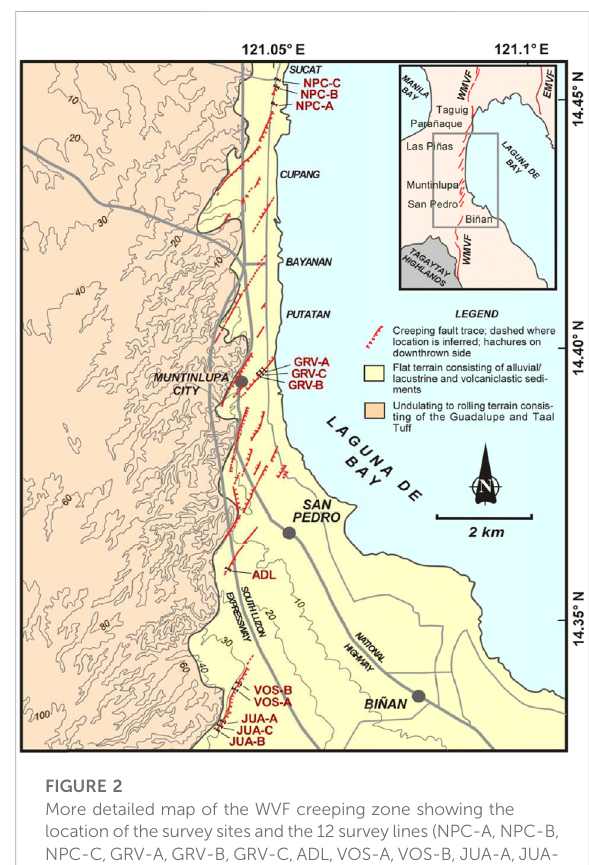
location ofthesurveysitesandthe12surveylines(NPC-A, NPC-B,